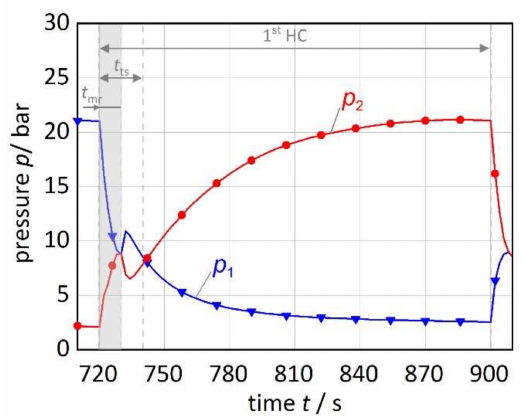
Figure 9. Transient course of the pressures p 1 for an exemplary 1st HC of the reference experiment between 720 and 900